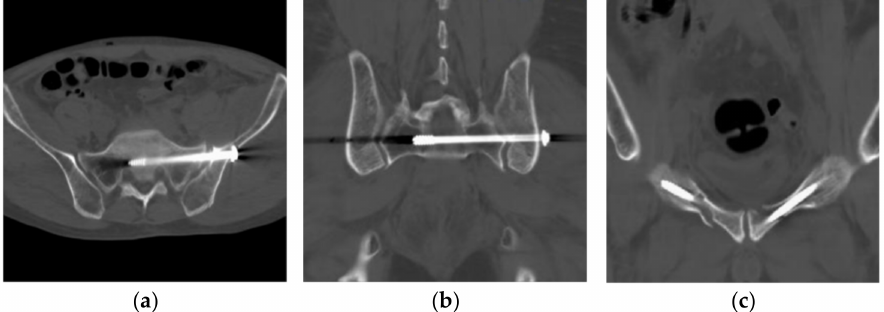
Figure 5. Post-operative CT scan to identify the reduction quality: ( a ) axial plane at the SI joint; ( b ) coronal plane at the SI joint view; ( c ) coronal plane at the anterior fracture